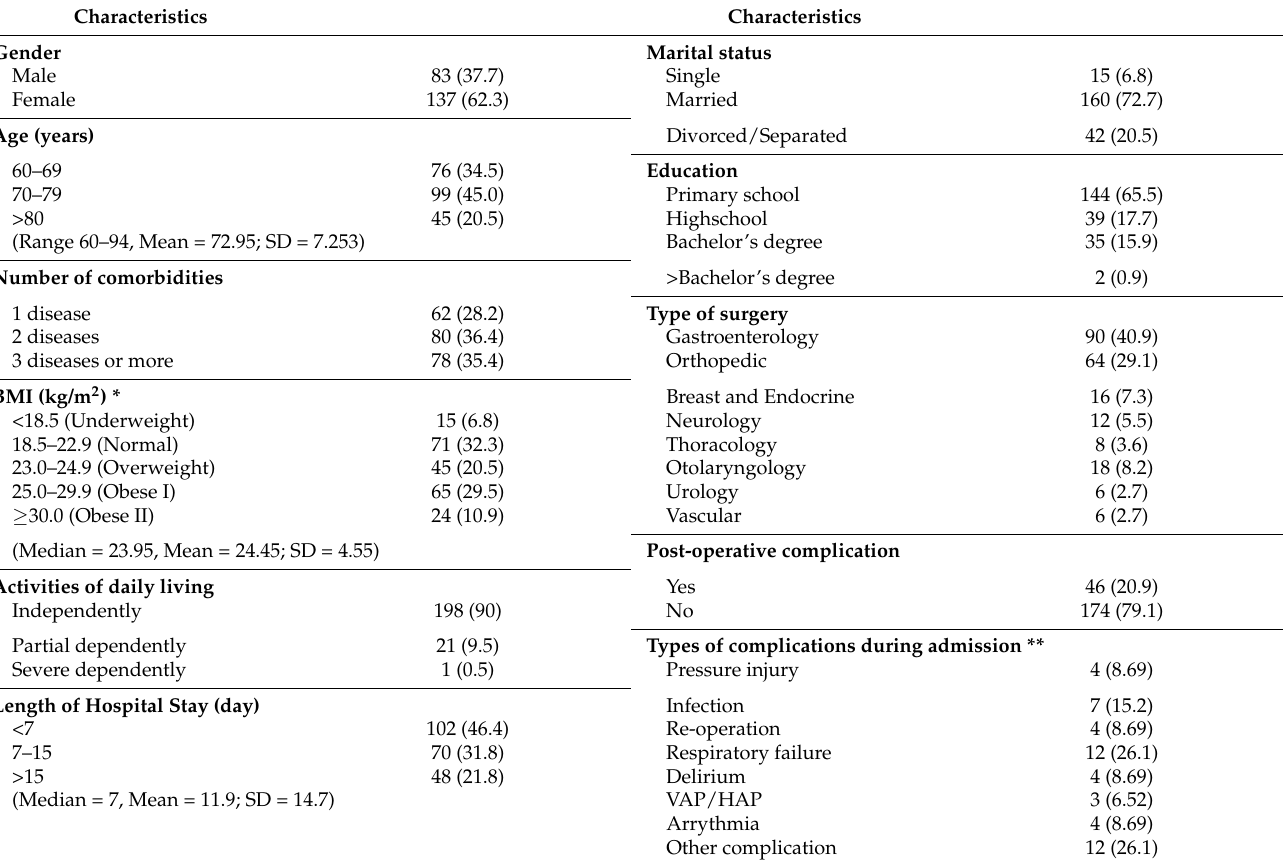
Table 1. Characteristics of study participants (n =